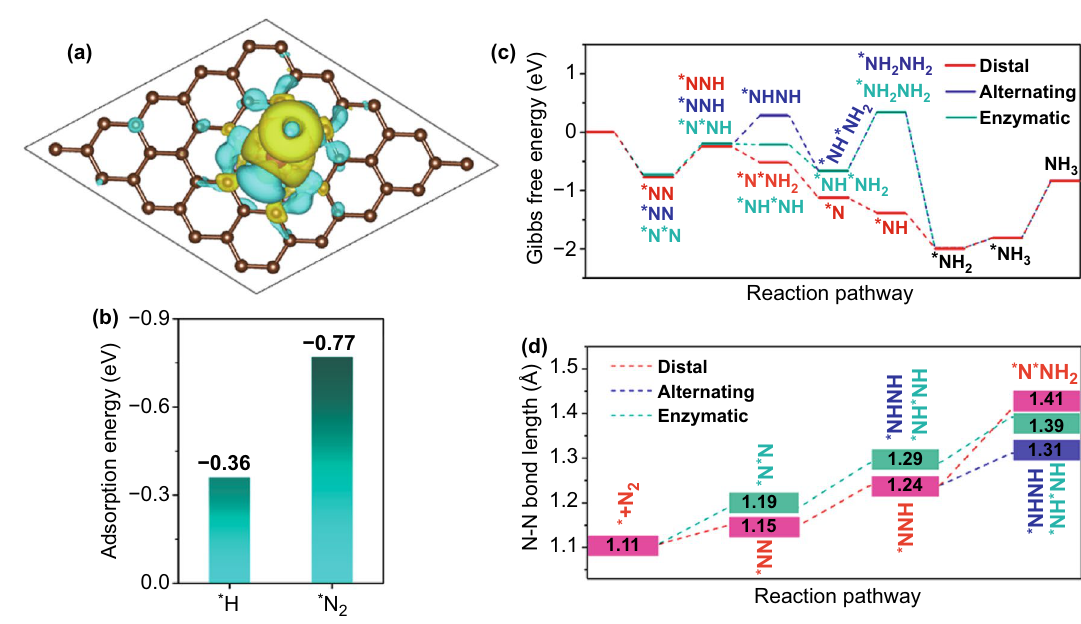
Fig. 4 a Charge differential distribution of Mn–N–C SAC after the adsorption of N 2 via end‑on mode. b Adsorption energy of *N 2 and *H on Mn site. c Gibbs free energy diagrams of distal, alternating and enzymatic pathways for N 2 reduction, and d the corresponding N–N bond length of the